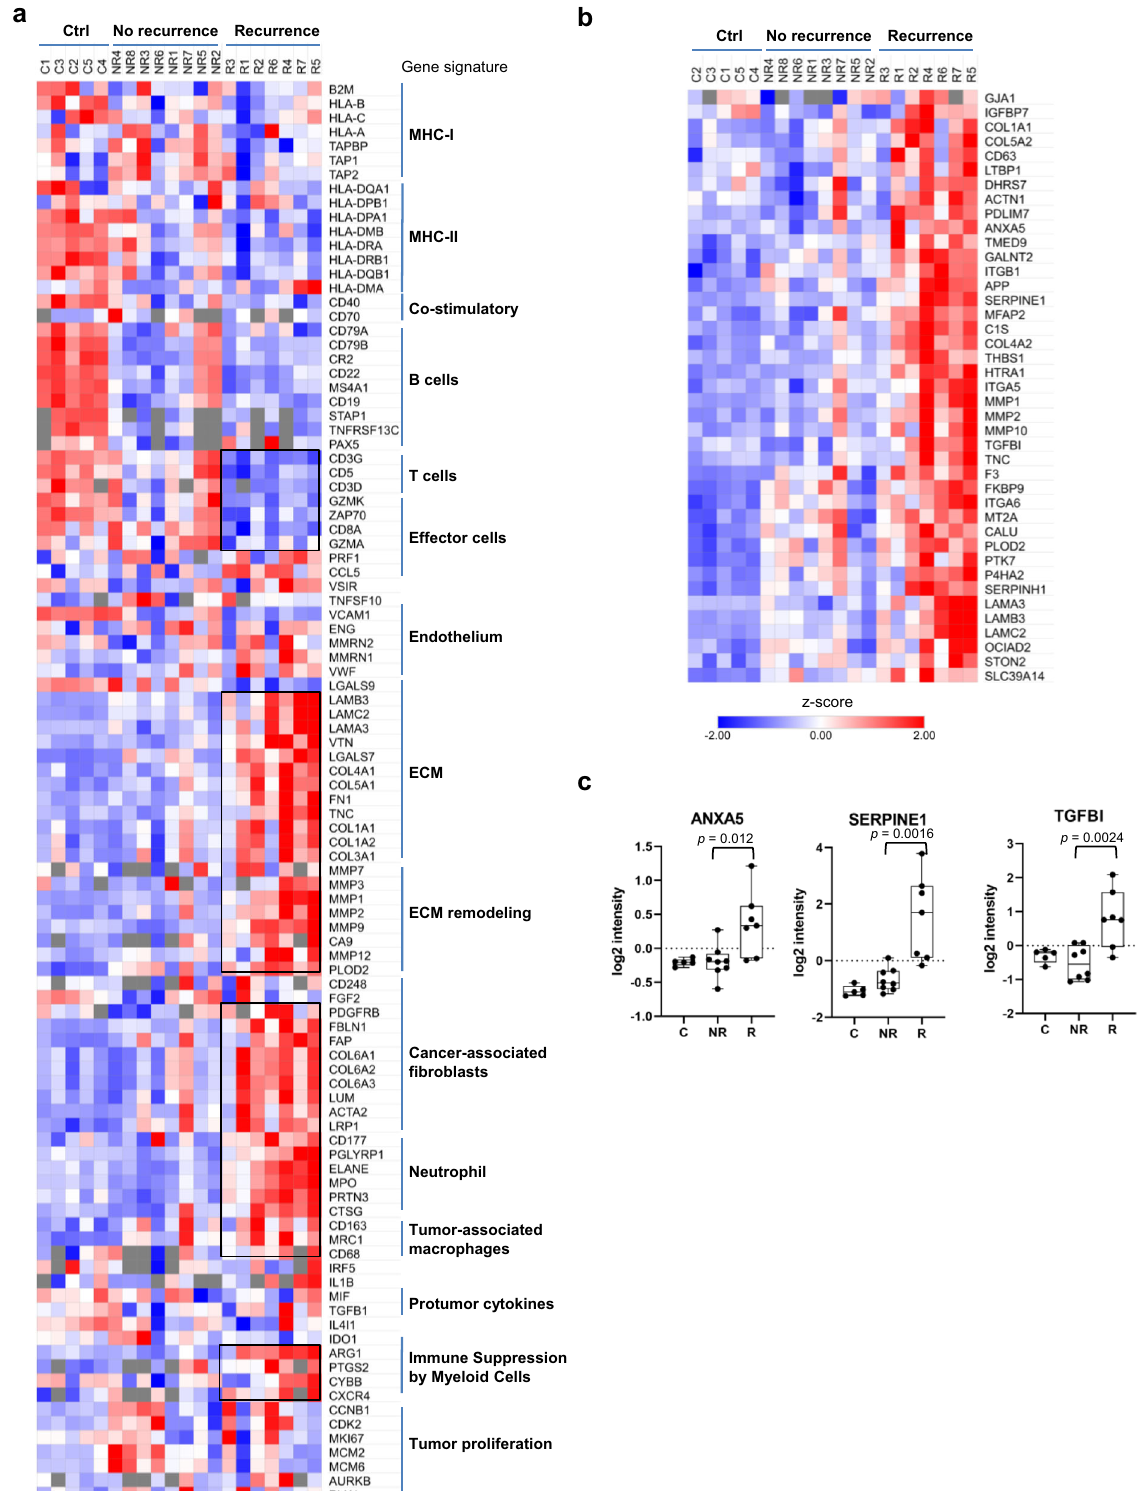
Fig. 2 Remodeling of the tumor microenvironment (TME) underpins recurrence. a Heatmap of functional gene signatures (Fges) to show the signi fi cant changes in cellular or extracellular components (boxed) in the recurrent compared to the non-recurrent groups and tonsil controls. ECM extracellular matrix. b An increased EMT potential is associated with recurrence. The recurrent tumors were characterized with signi fi cantly increased expression of the markers for a partial EMT program ( p < 0.1 between the NR and R groups). c Representative examples of pEMT markers with signi fi cant differences in expression between recurrent and non-recurrent samples. The box in a the box plot extends from the 25th to the 75th percentile. The whiskers go down to the smallest value and up to the largest. For the panels b and c , n = 8 for the NR group, and n = 7 for the R